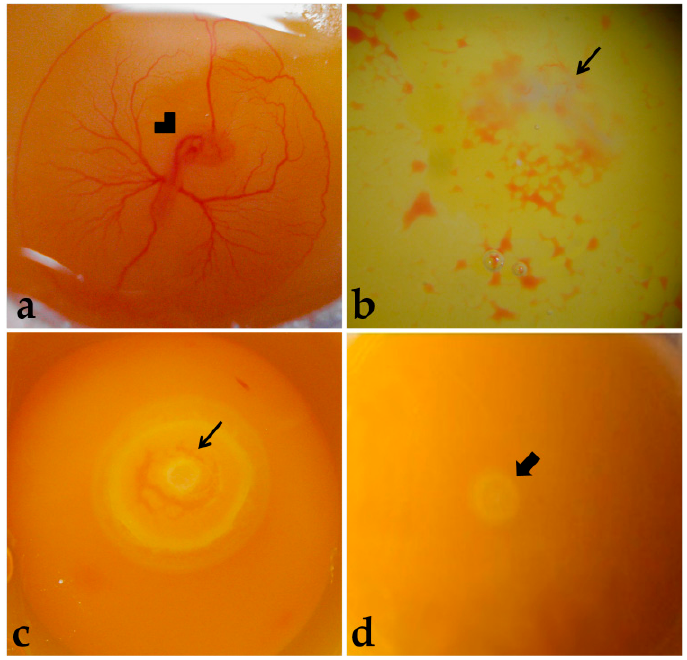
Figure 2. Embryo viability. ( a ) Live embryo (72 h). ( b , c ) Dead embryos. ( d ) Embryo classified as not having development resumed with incubation. Arrowhead: Embryo. Thinner arrow: Dead embryo. Thicker arrow: Blastoderm.